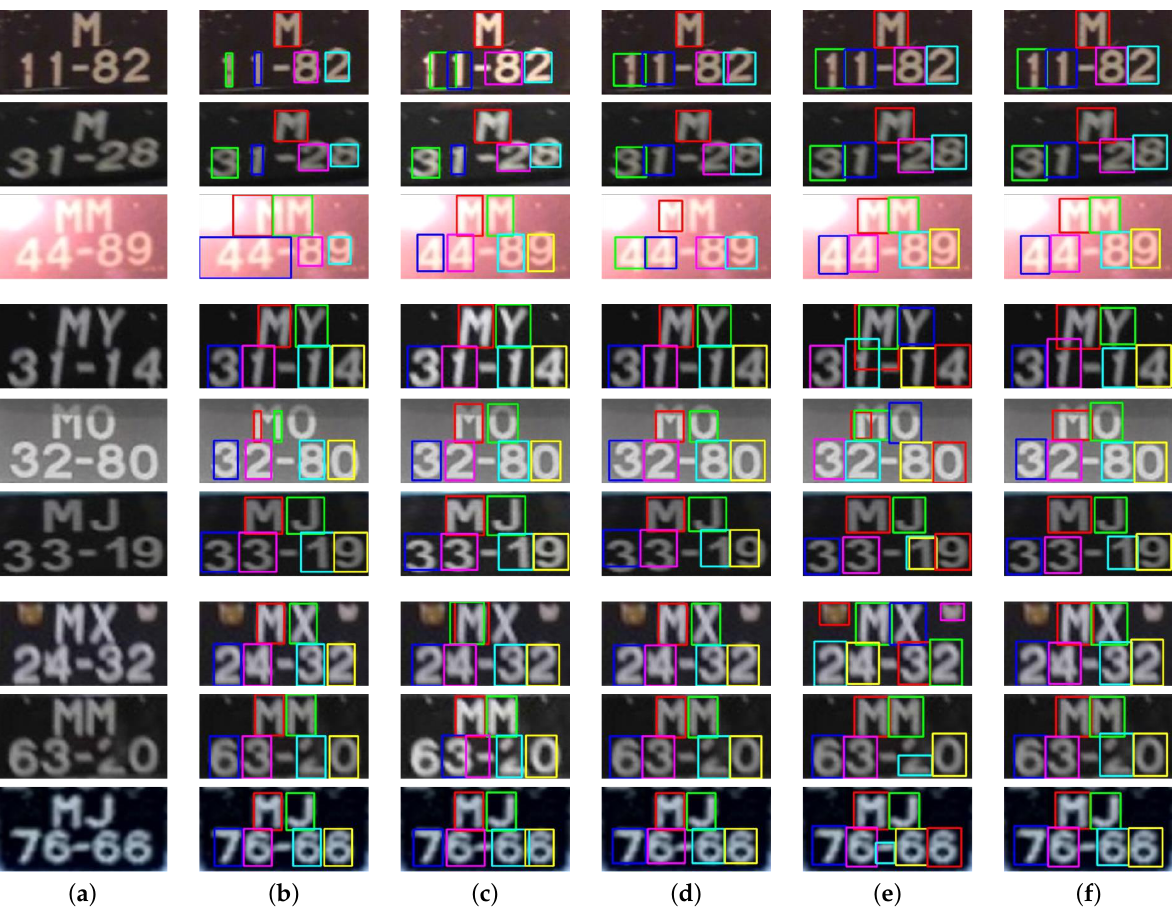
Figure 8. Some segmentation results of double-row license plates. ( a ) Input images. ( b ) Projection- based [13]. ( c ) MSER-based [17]. ( d ) CCA-based [19]. ( e ) ROI-based [33]. ( f )